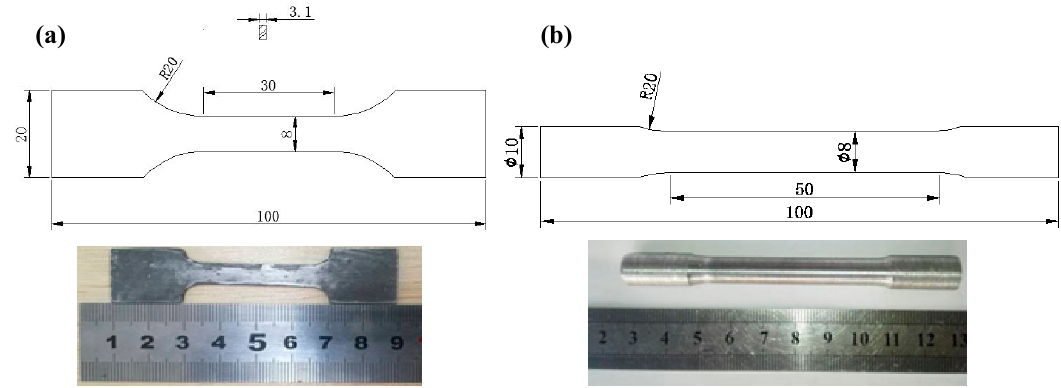
Figure 1. Tensile specimens of the CF / Al composite ( a ) and the as-cast Al-10 Mg alloy ( b ). The unit for the dimensions is millimeters.